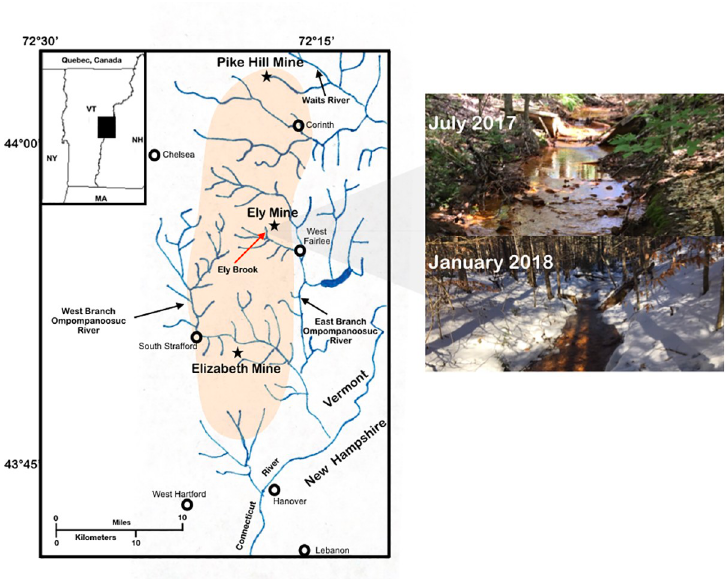
Fig 1. Vermont copper belt. Map of Elizabeth Mine, Ely Copper Mine, and Pike Hill Copper Mine (represented by stars) [4]. Circles represent nearby towns and the Ely Brook (EB-90M) study site is indicated by a red arrow. The pictures on the right show the EB-90M study site on July 28 th , 2017 and January 14 th ,